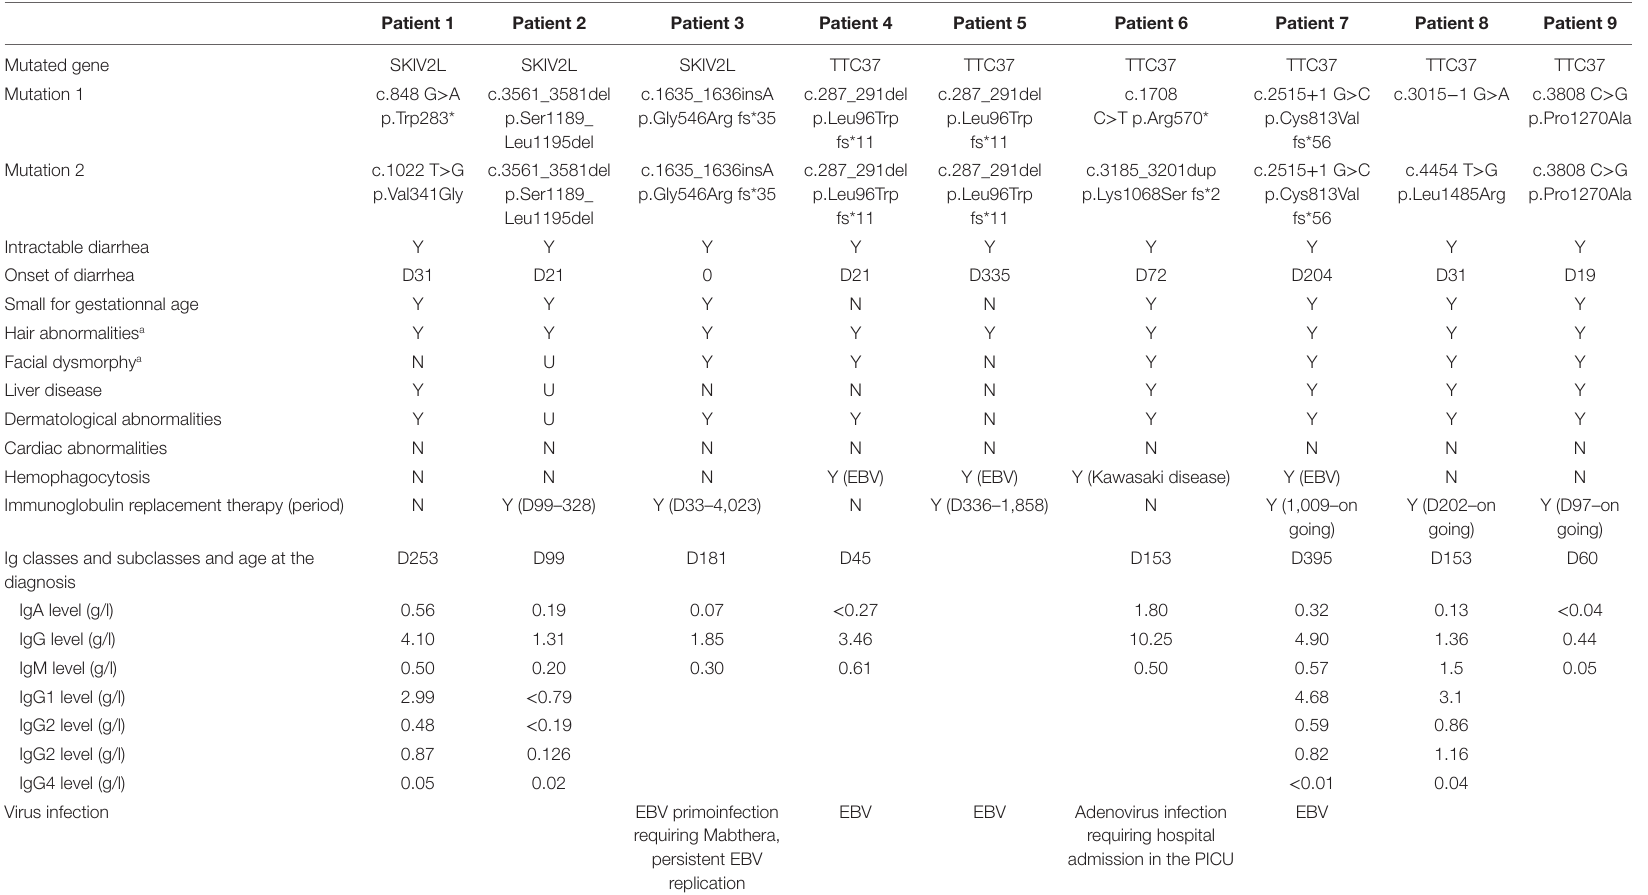
taBLe 1 | Patients characteristics.